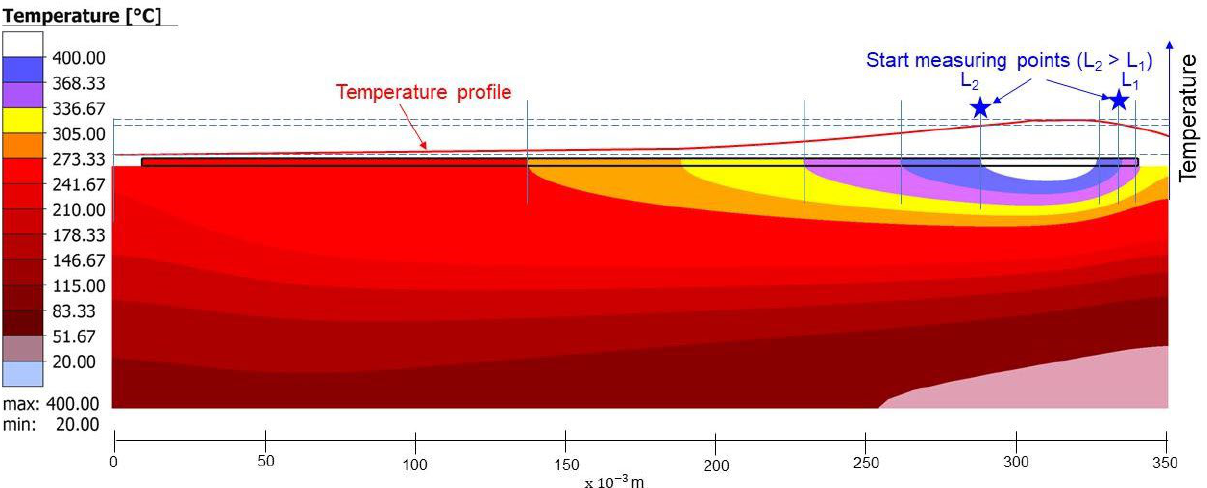
Figure 9. Numerical simulation of an HSLA steel thin wall WAA Manufactured, 21 s after extin- guishing the heat source: substrate length = 350 mm; layer length = 330 mm; layer width = 5.3 mm, arc energy = 422 J/mm (adapted contribution from Dr Amin Rahimi, personal communication).